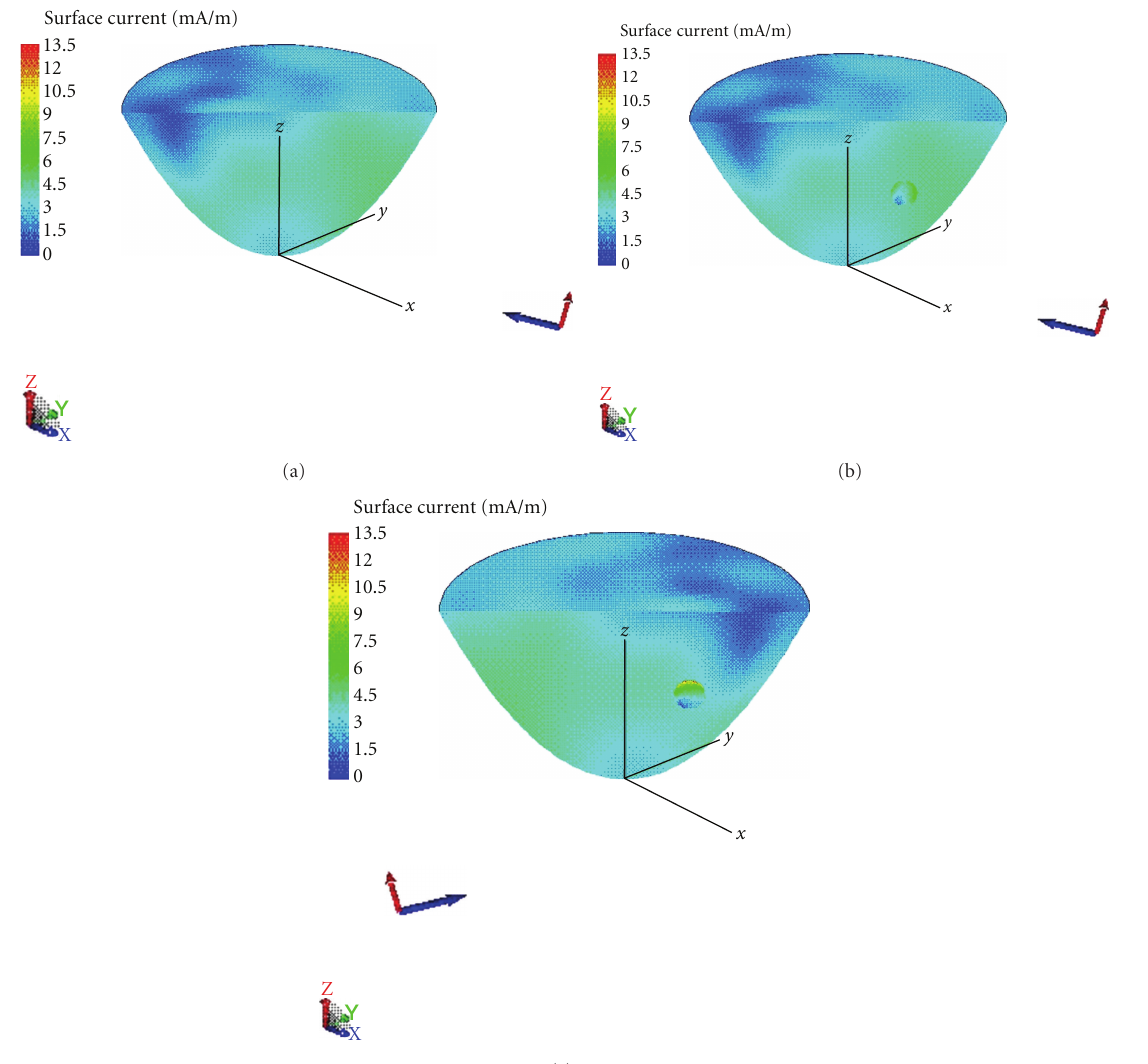
Figure 8: (a) Current distribution of the breast volume under the plane wave excitation with vertical polarized electric field from the aspect of θ t = 105 ◦ , ϕ t = 45 ◦ . (b) Current distribution of the breast volume with the 5 mm tumor under the plane wave excitation with vertical polarized electric field from the aspect of θ t = 105 ◦ , ϕ t = 45 ◦ . (c) Current distribution of the breast volume with the 5mm tumor under the plane wave excitation with vertical polarized electric field from the aspect of θ t = 105 ◦ , ϕ t = 225 ◦